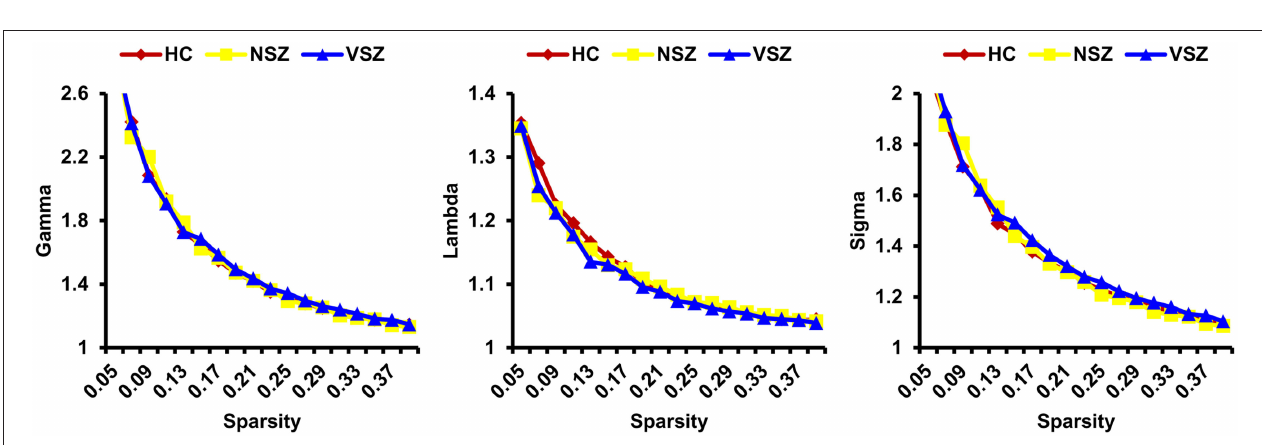
FIGURE 2 | All the HC, NSZ, and VSZ groups showed small-worldness properties of the individual morphological covariance network at sparsity values ranging from 0.05 to 0.39. HC, healthy control; NSZ, nonviolent schizophrenia; VSZ, violent schizophrenia.